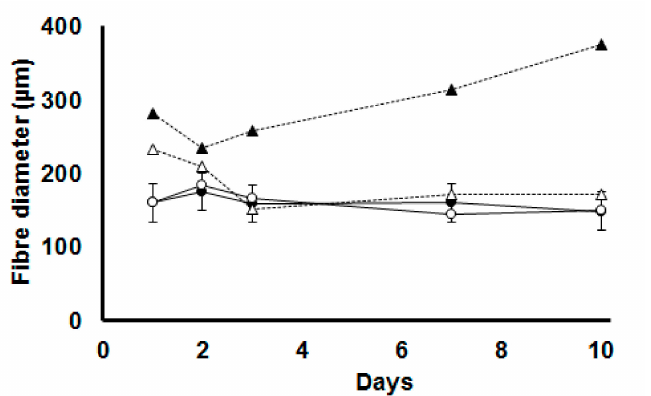
Figure 6. Psoas major fibre diameter in broilers fed either a control diet (CON, round symbols) or betaine supplemented diet (BET, triangle symbols) after 1, 3, 7 and 10 days of being exposed to either thermoneutral (TN, filled symbols) or heat stress (HS, open symbols) conditions. Psoas major fibre diameter increased over the course of experiment in TN BET ( p < 0.001) while HS groups reduced HS CON. The standard error of the di ff erence for Temperature × Diet × Day is displayed on the data for the chickens fed the CON diet under TN